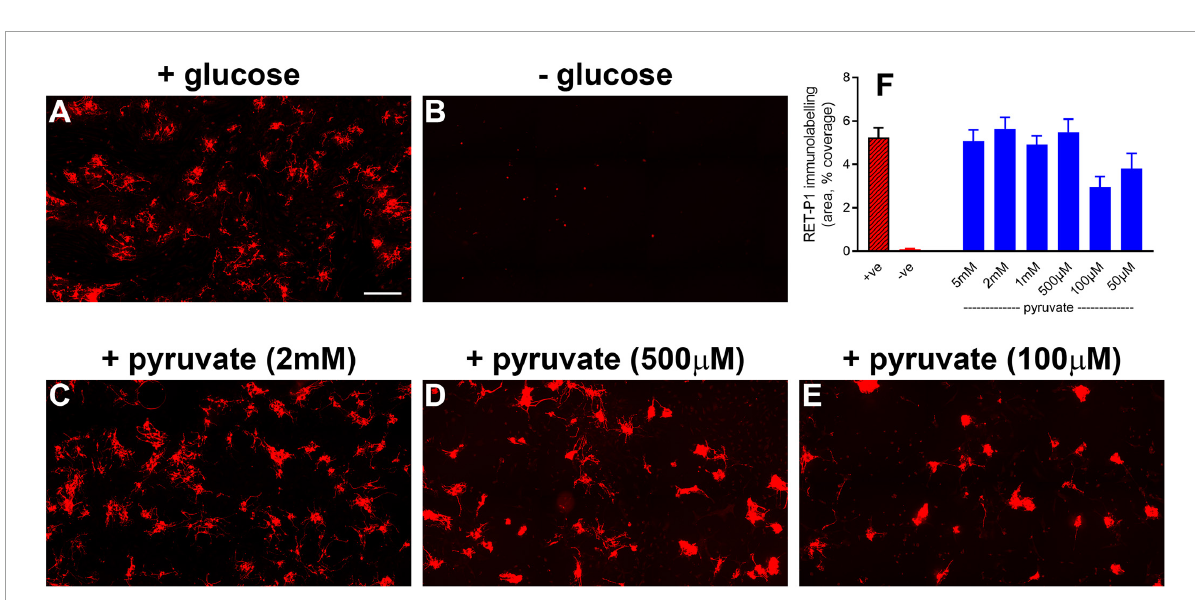
FIGURE9 Pyruvate protects against hypoglycemia-induced death of photoreceptors in mixed retinal cultures. (A–E) Representative images of RET-P1 (rhodopsin) immunolabelling in mixed retinal cultures subjected to normal medium (A) , nutrient deprivation (B) , or nutrient deprivation plus pyruvate (C–E) . Scale bar: 200 µ m. (F) Quantification of RET-P1 immunolabelling. Values, shown as % of the +glucose group, represent mean ±